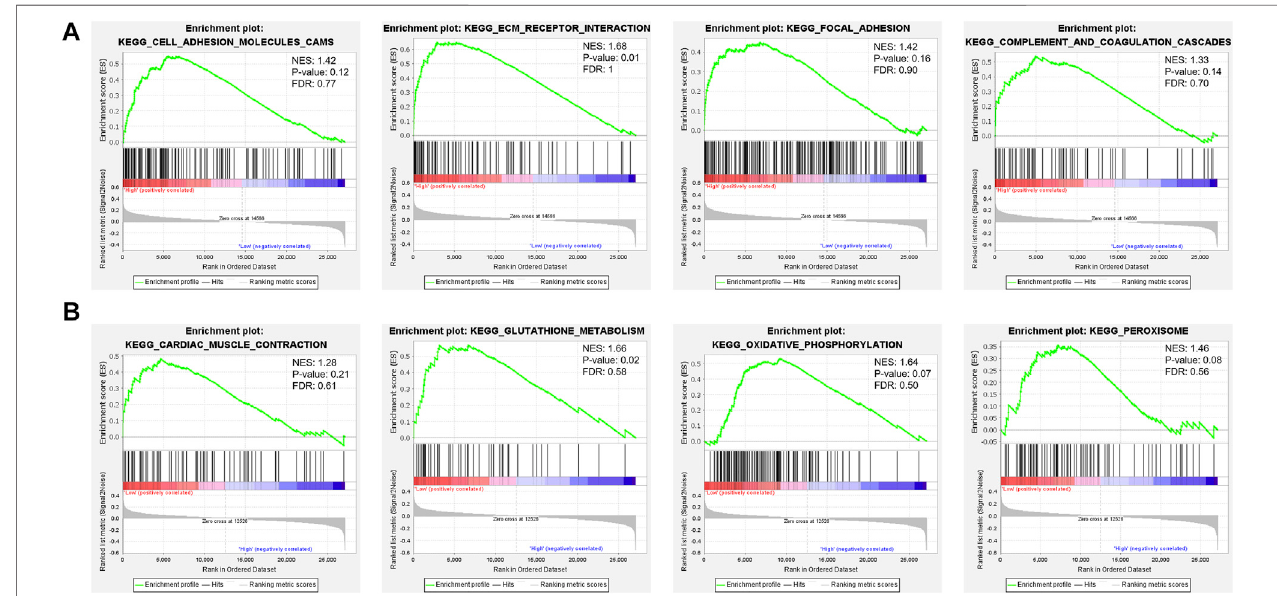
FIGURE 3 | GSEA of FPI-high and FPI-low groups. (A) FPI-high group; (B) FPI-low group.